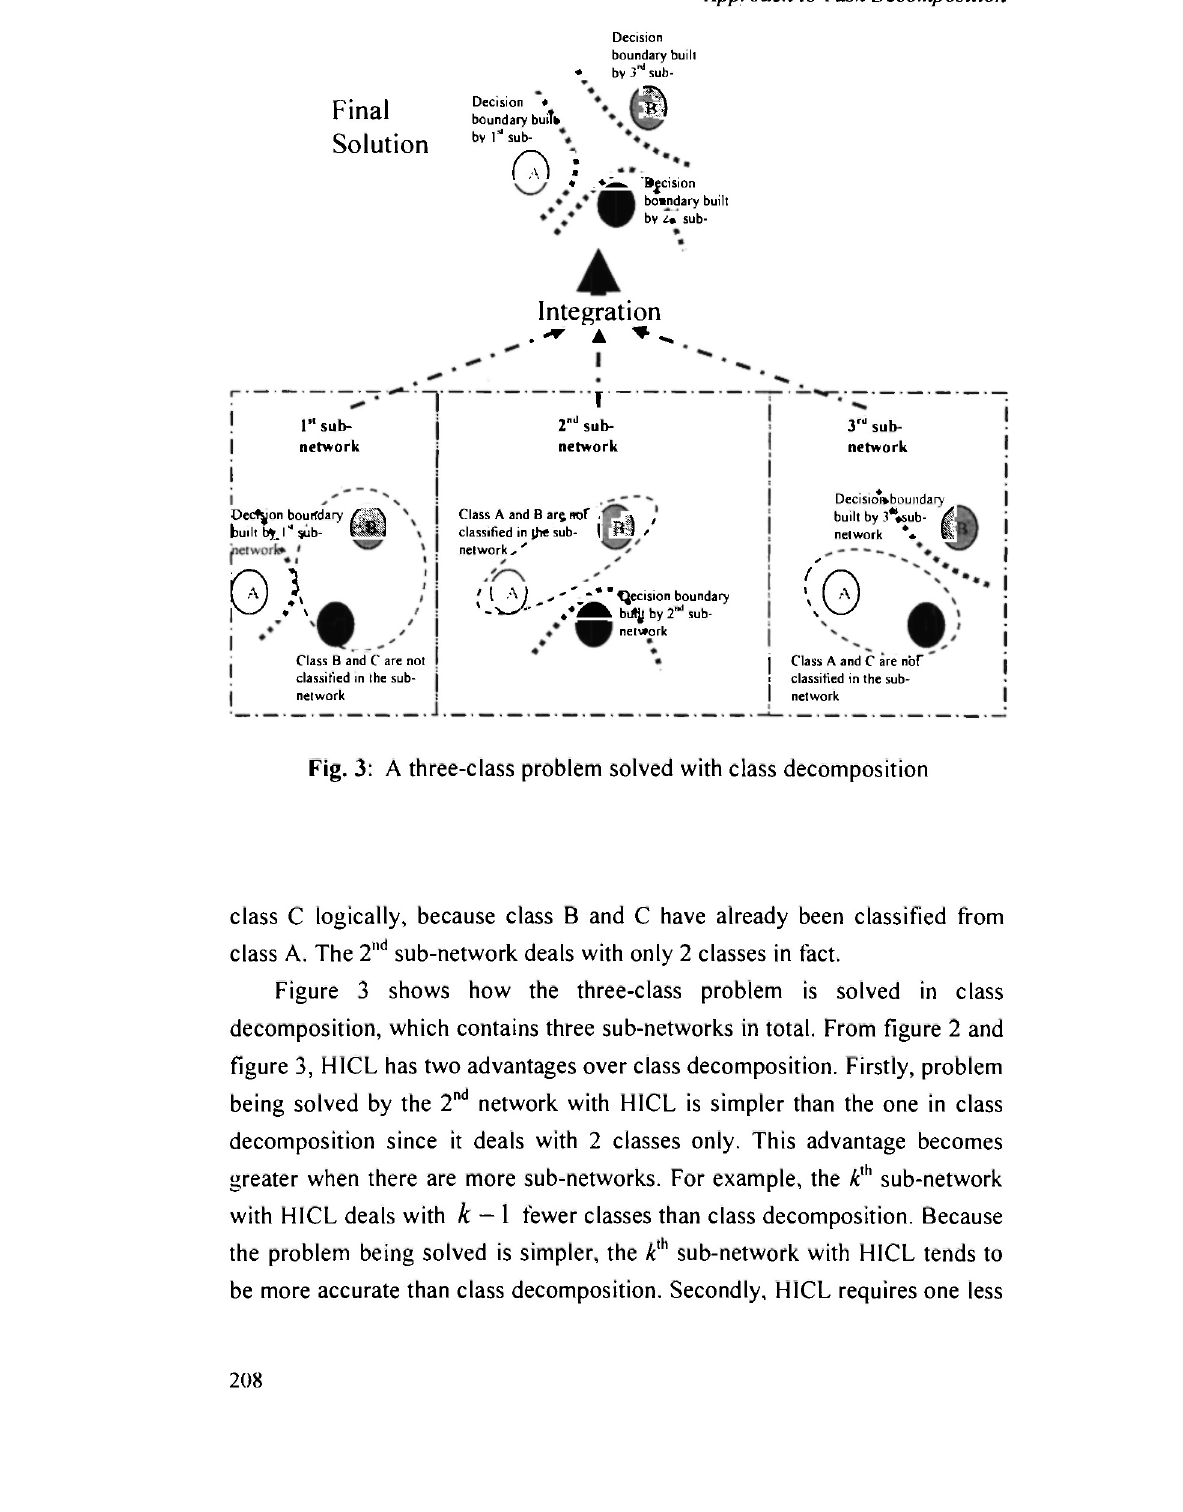
Fig. 3: A three-class problem solved with class decomposition